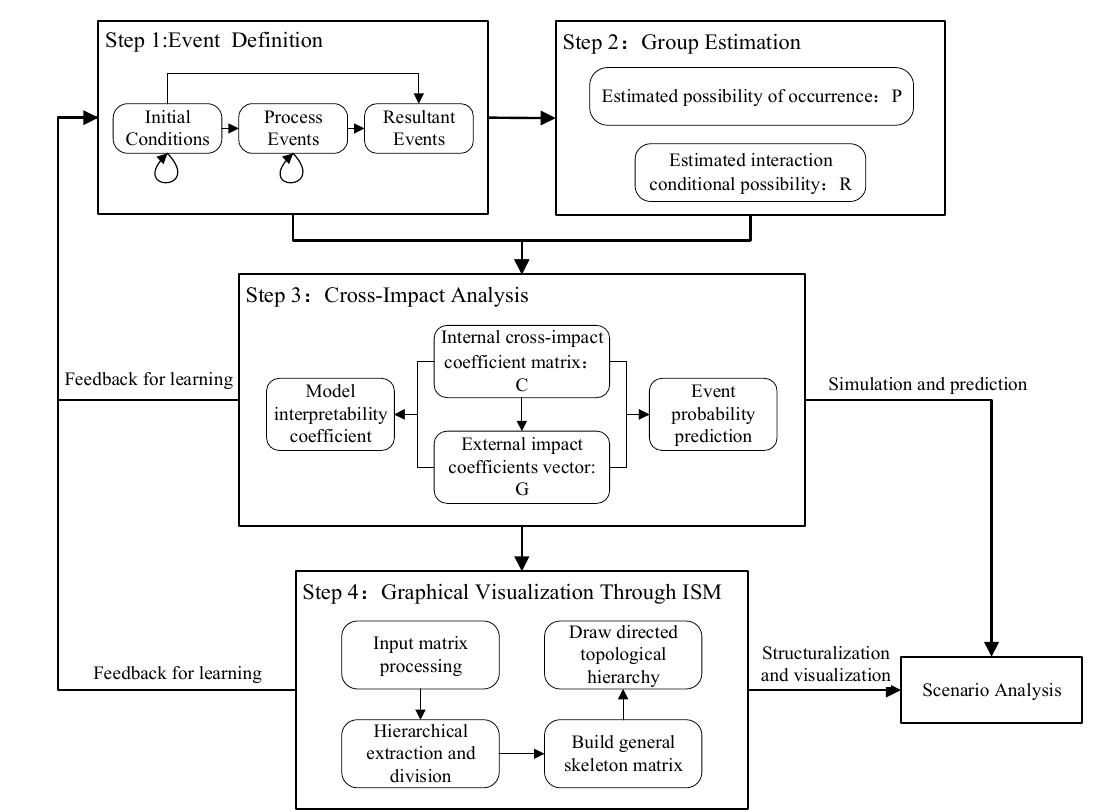
Figure 1. The process of CIA-ISM.